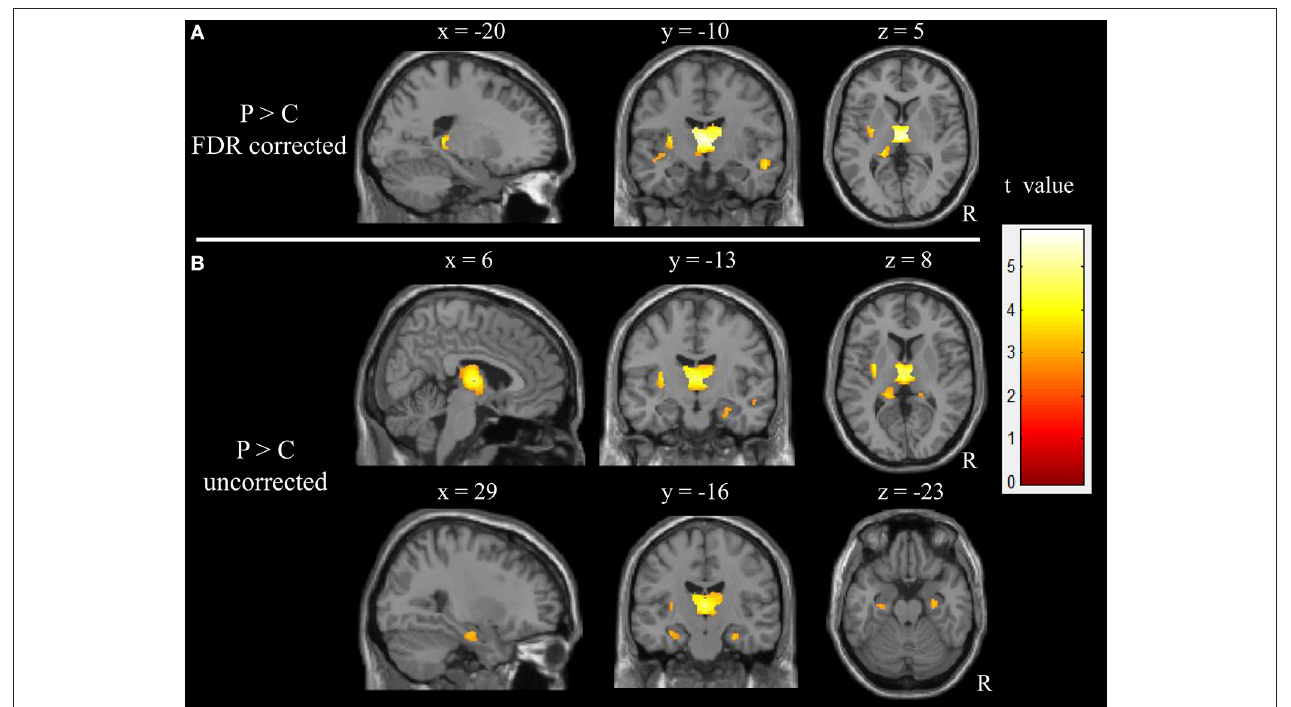
FIGURE 1 | Significant changes of GM volume in children with epilepsy. (A) The threshold of whole brain: p < 0.05, FDR corrected, cluster size > 15; (B) The threshold of whole brain: p < 0.001, uncorrected, cluster size > 15. The color intensity represents T-statistic values at the voxel level. P, patients; C, normal controls; R, right